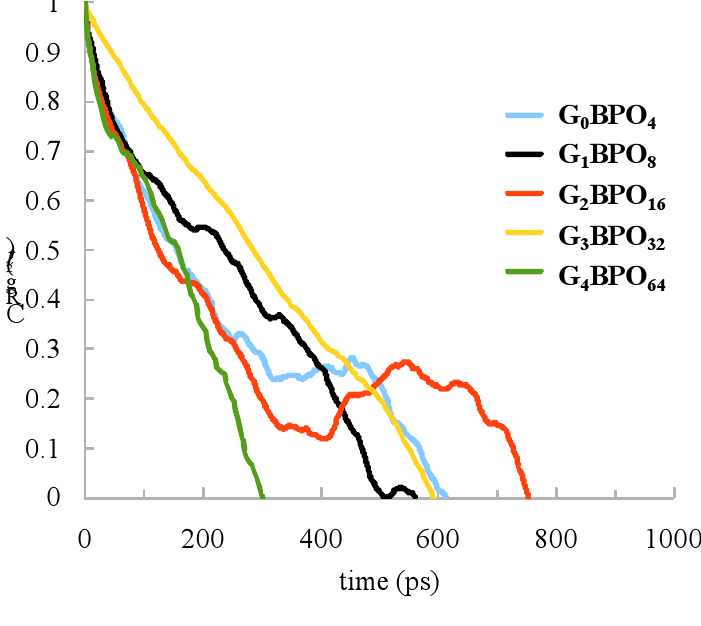
Figure 6. Correlation functions of squared radius-of-gyrations for dendrimers G (n =